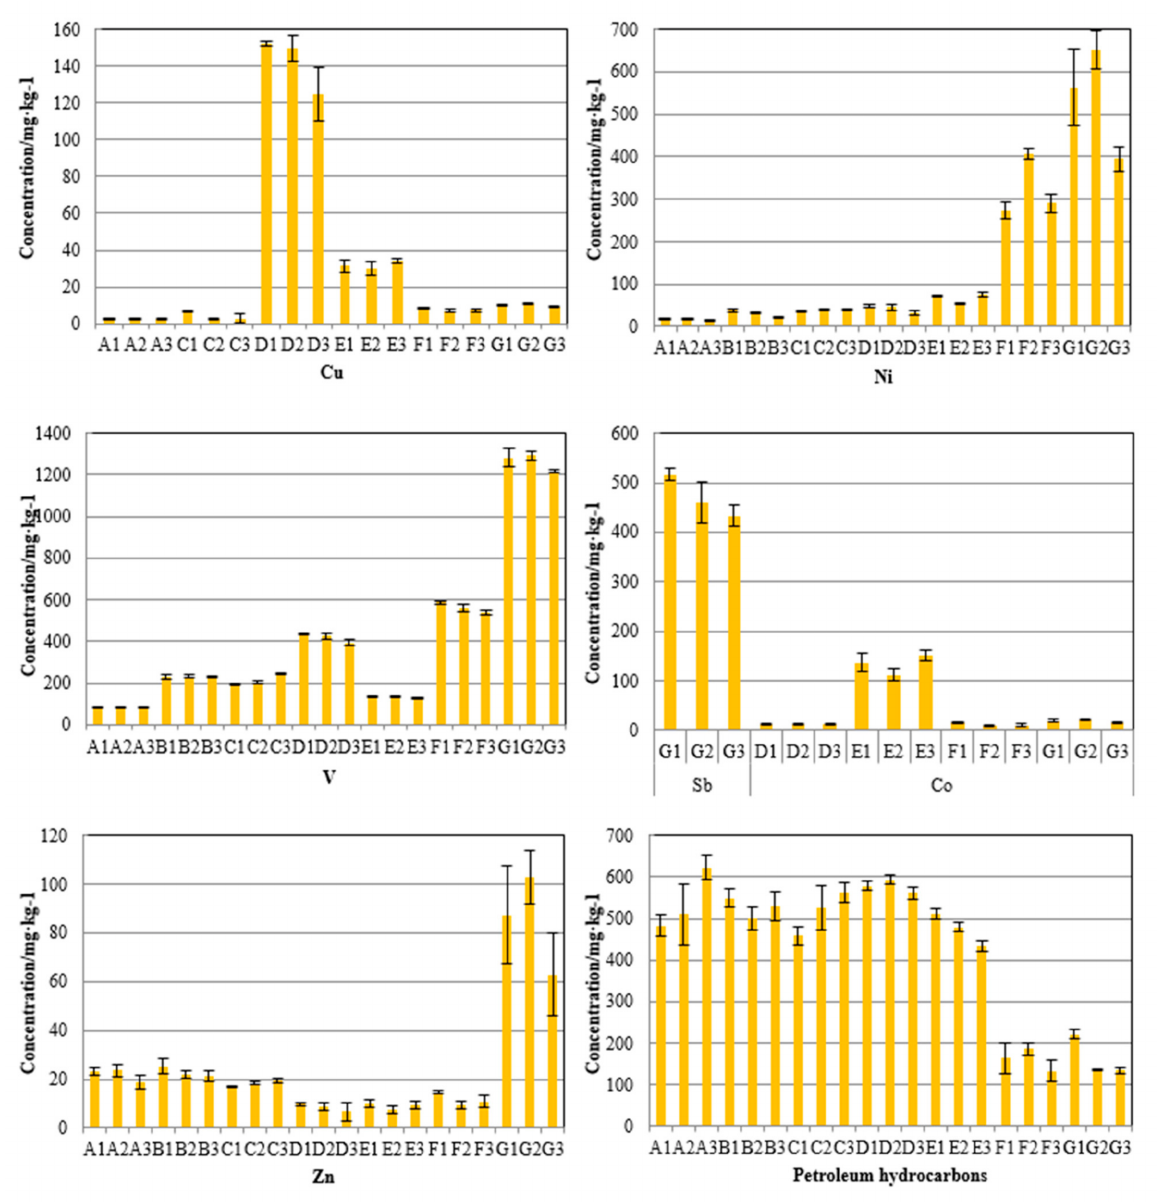
Figure 2. FCC spent catalyst characteristic pollutant